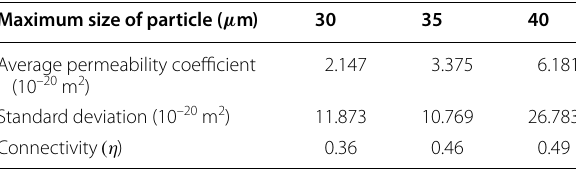
Table 5 Model simulation result for different maximum size of cement particle with w/c ratio-0.5.